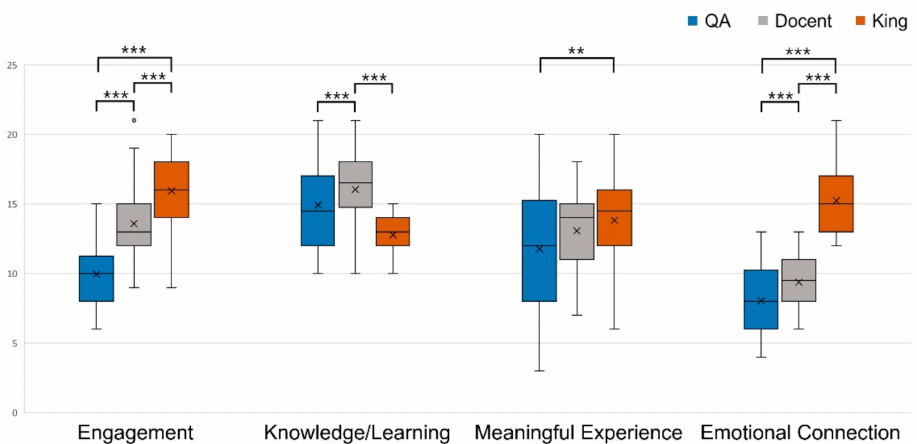
Figure 3. MES results on the three chatbot models. (significance p -value **: p < 0.01, ***: p <